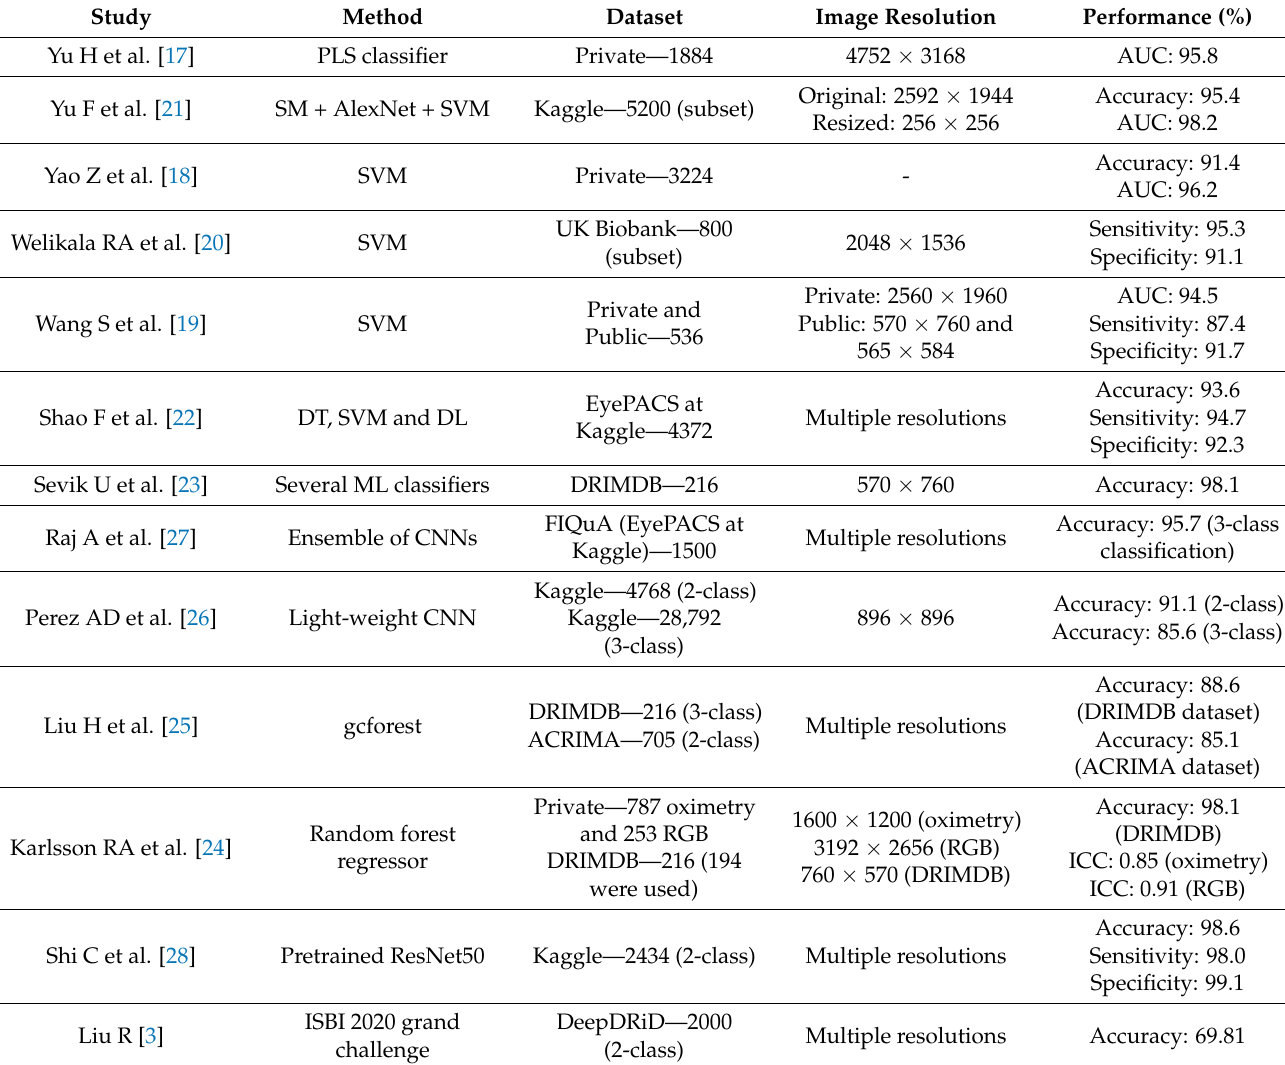
Table 1. Previous works on assessing the fundus image quality using different machine learning and deep learning methods on various private and public